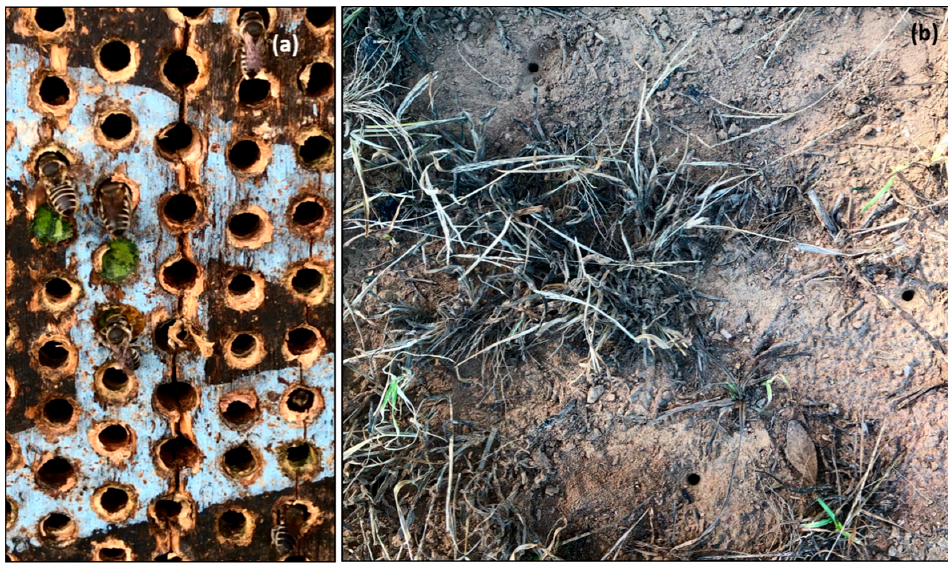
Figure 1. Leafcutter bees constructing nest in a drilled wood block ( a ) while ground-nesting solitary bees prefer well-drained patches in bee habitat for nest construction ( b ). Pictures by N. Joshi.